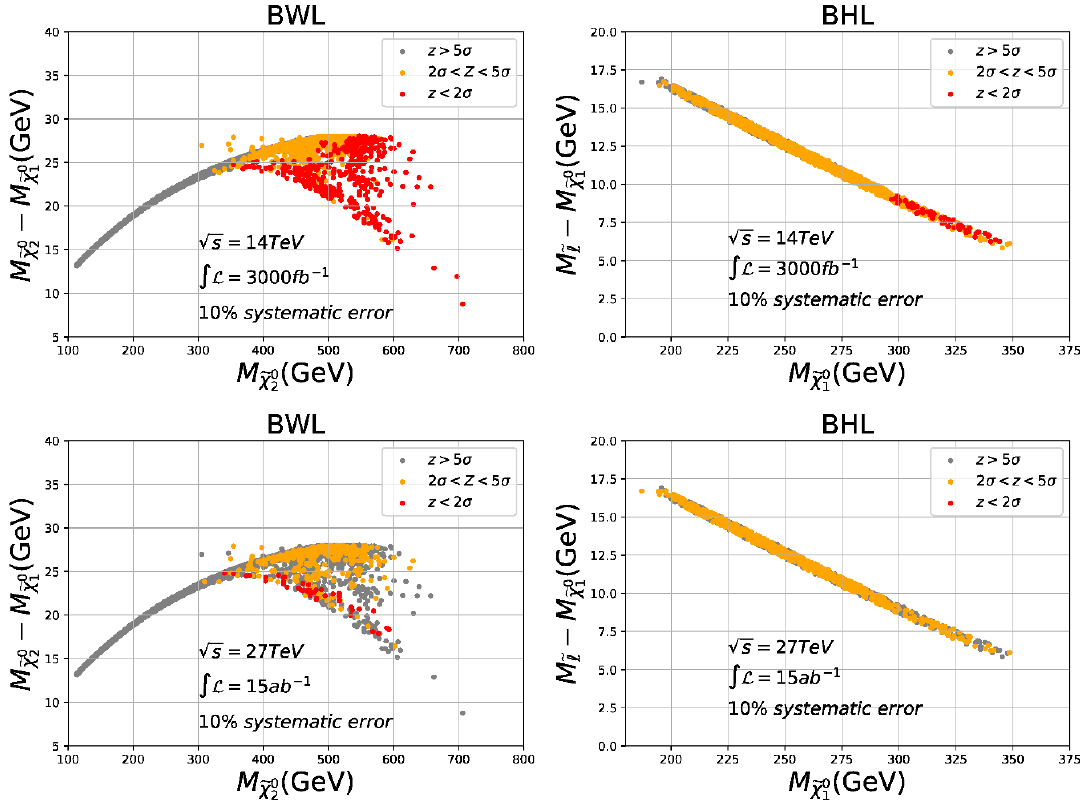
Figure 6 . Same as (cid:12)gure 3, but showing the signi(cid:12)cance of the processes pp ! ~ (cid:31) 0 pp ! ~ ‘ ~ ‘ + jets at the HL-LHC and HE-LHC. The left and right panels are for the BWL and BHL scenarios,